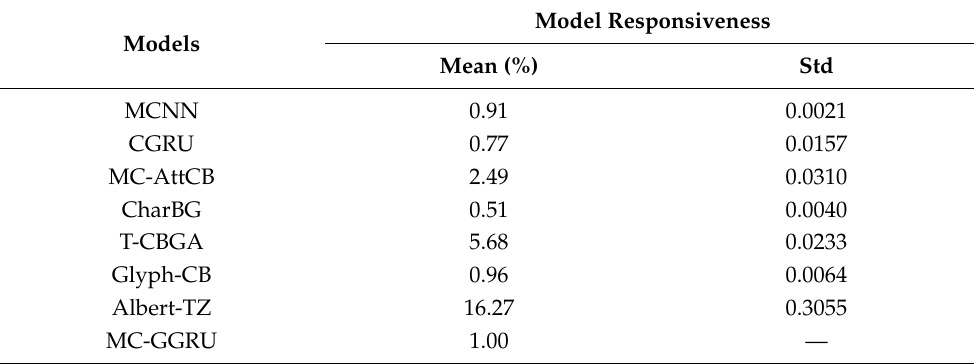
Table 4. The relative processing speed compared to our proposed model after five repetitions on the inference process.